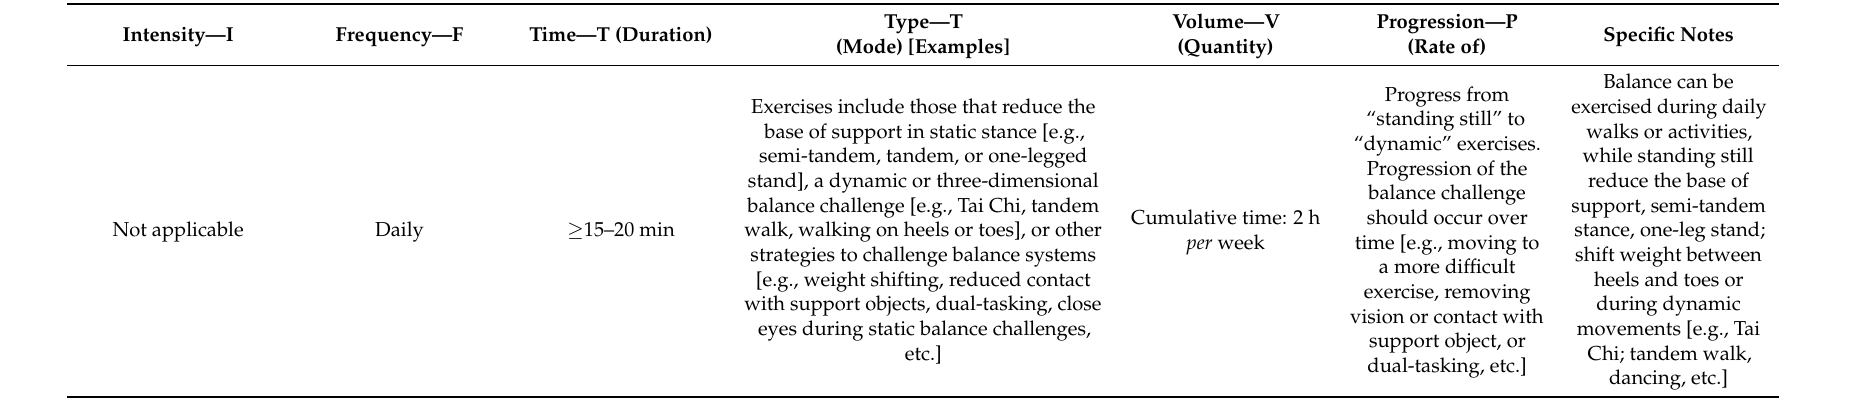
Table 4. Balance exercise recommendations for ageing postmenopausal